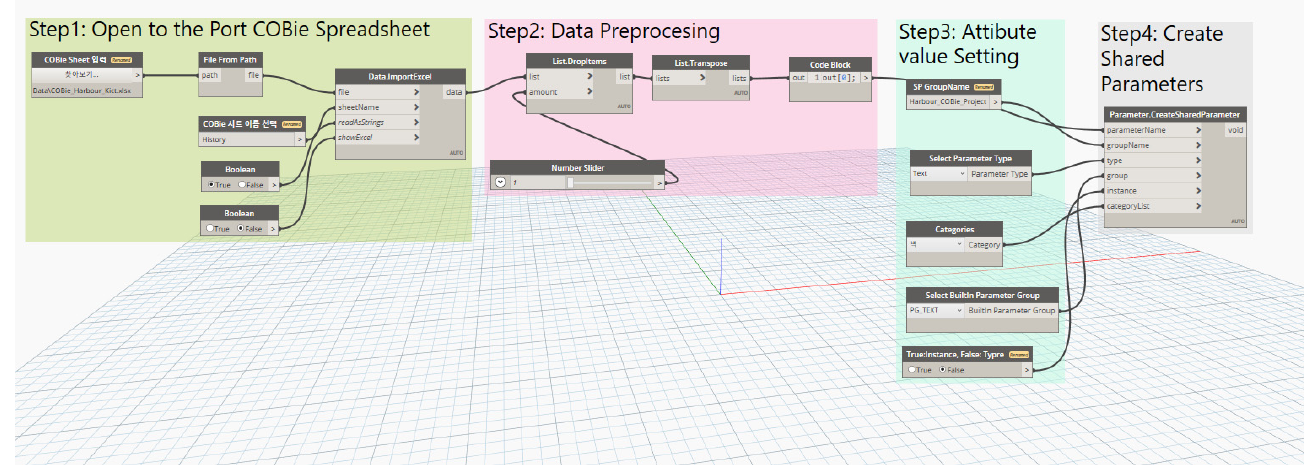
Figure 14. For creating shared parameters based on the port COBie for implementing port COBie input system.